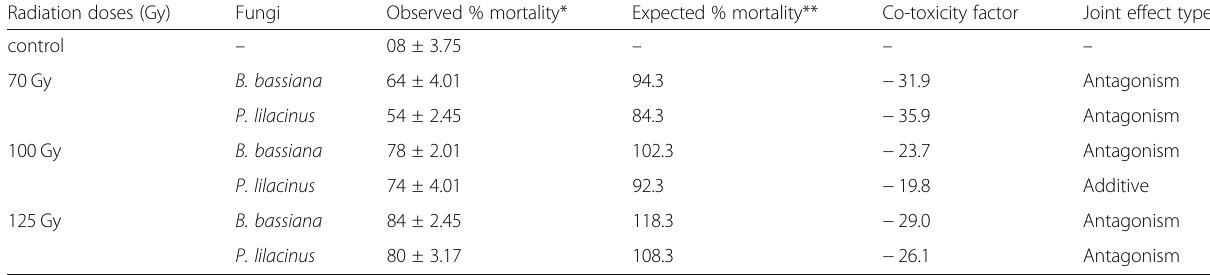
Table 5 Potency of interaction between of gamma irradiation and LC 50 of the entomopathogenic fungi, Beauveria bassiana and Radiation doses